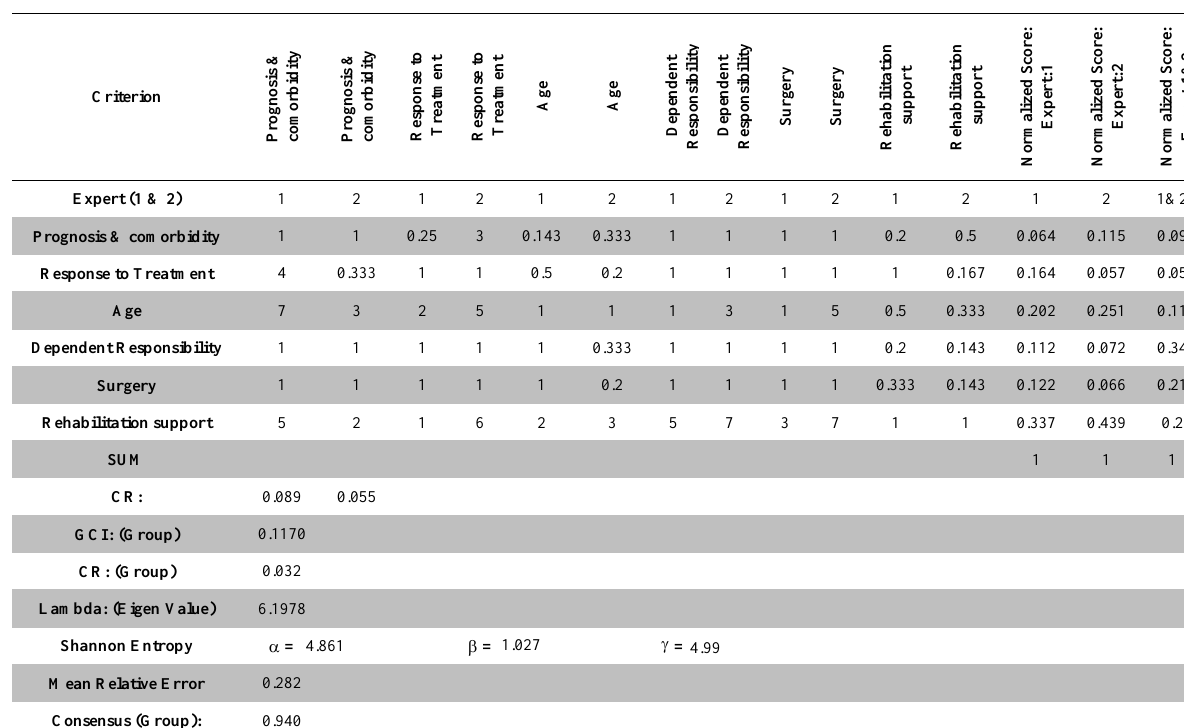
Table 11. Decision Matrix A: About Patient Case 2 (Expert 1 and